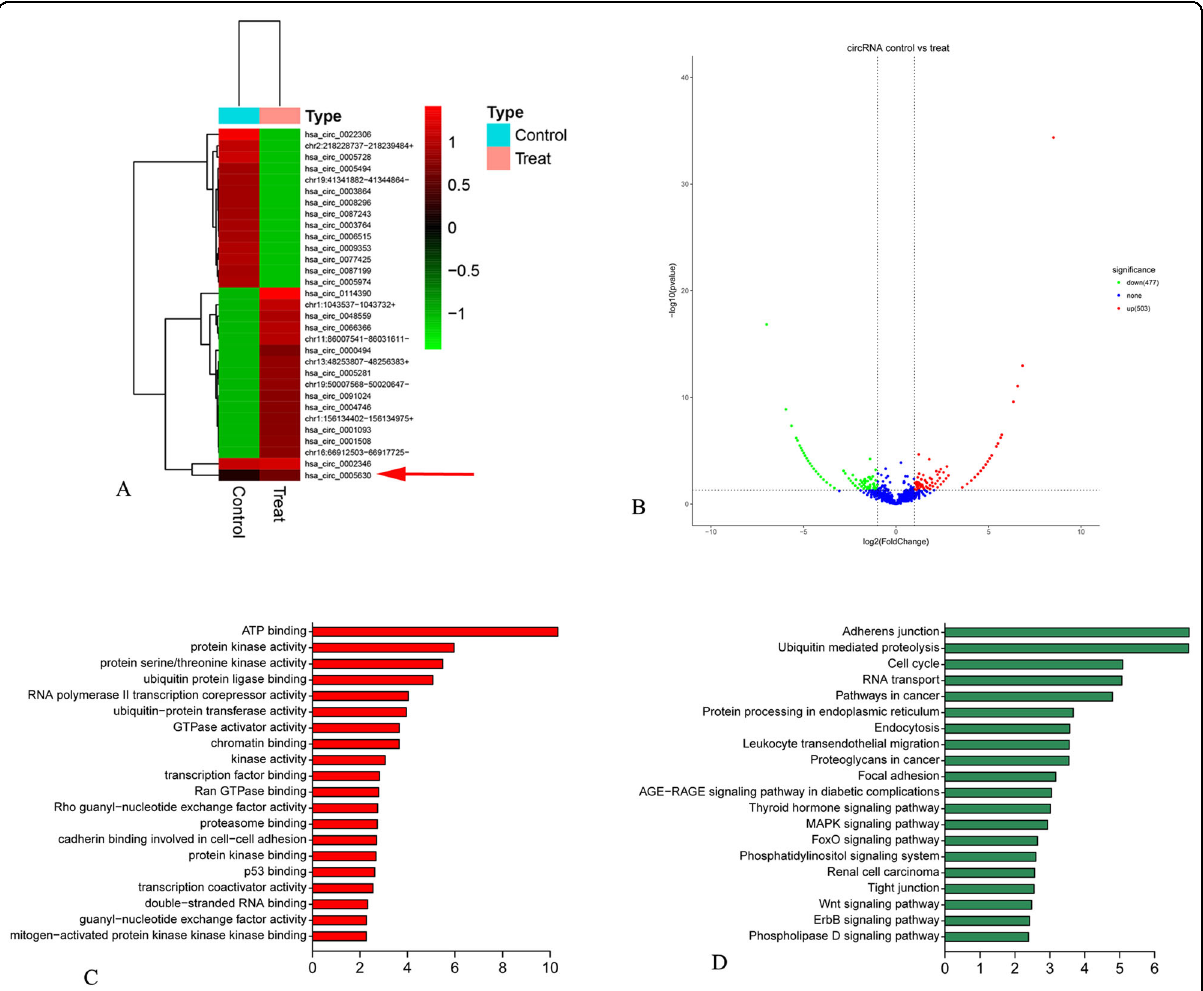
Fig. 1 Discovery of differential circRNAs in Torin 1-treated SKOV3 cells. A Hierarchical clustering analysis on differential circRNAs between Torin 1 treatment (10 µM) and controls. Heatmaps were plotted according to the 30 most signi fi cant differential circRNAs. The “ red ” and “ green ” colors suggest upregulation and downregulation, respectively. B Volcano map for the 30 most signi fi cant differential circRNAs. C Functional analysis for the 30 most signi fi cant deferential circRNAs. D KEGG pathway enrichment analysis for the 30 most signi fi cant differential